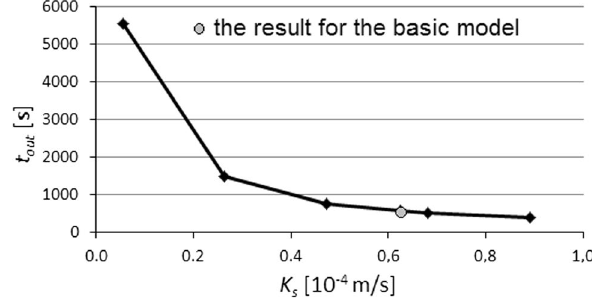
Fig. 3 Graph of the dependence between the time of water outflow on the soil surface after a failure of a buried water pipe ( t out ) and a satu- rated conductivity coefficient K s Table3 Selected formulas for determining the hydraulic condition for the